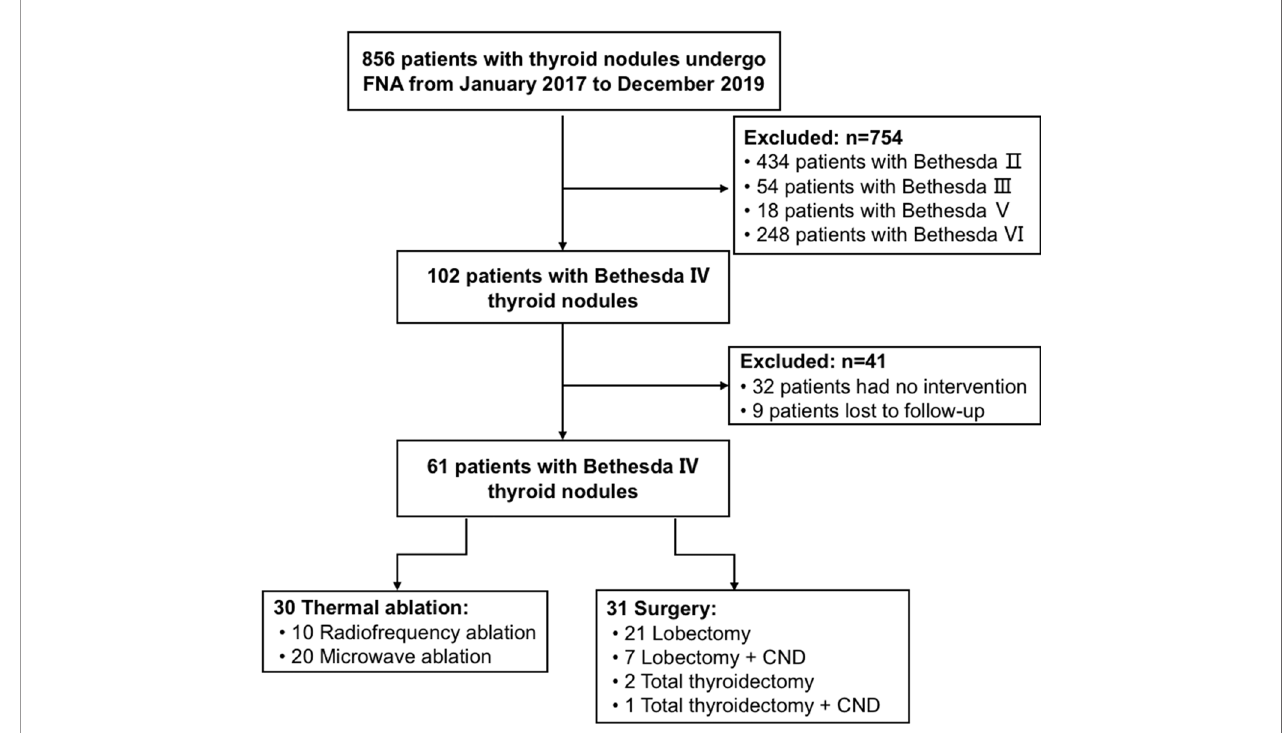
FIGURE 1 | Flowchart summarizing the patient inclusion process. CND is the abbreviation of central lymph node